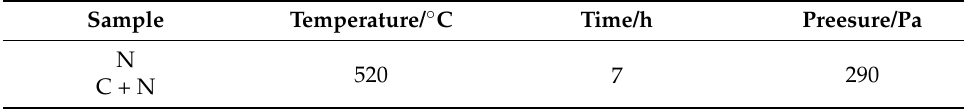
Table 3. Nitrided treatments of the C and the original